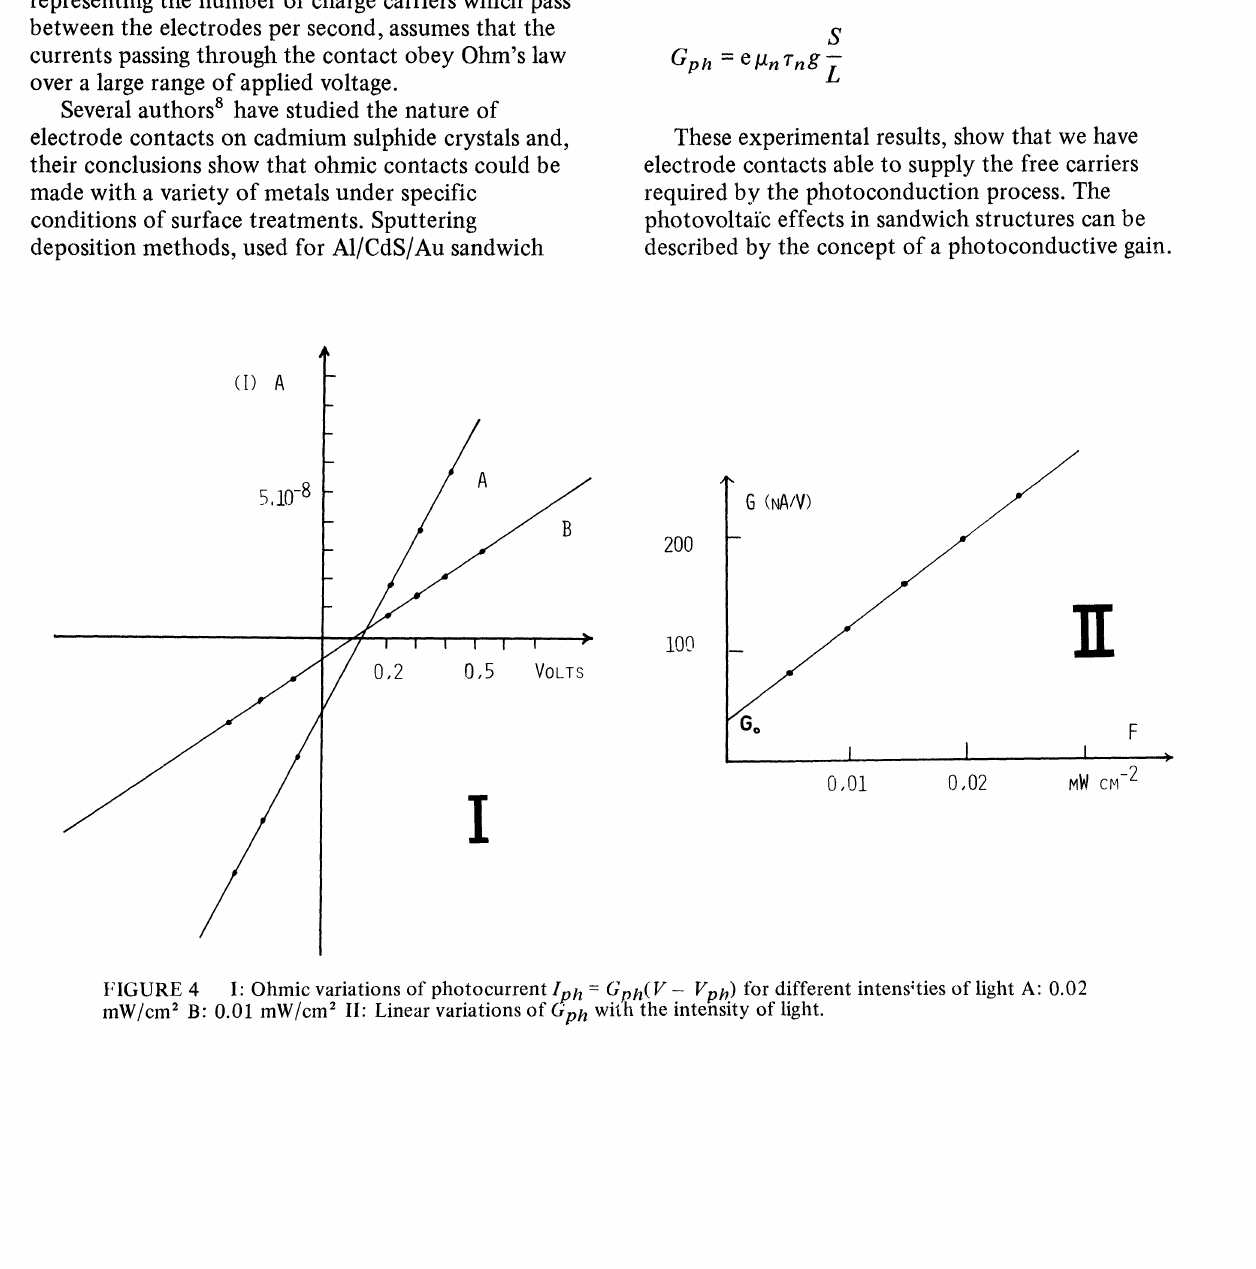
I: Ohmic variations of photocurrent Ioh- Gph(V- Vph) tbr different intensities of light A: 0.02 mW/cm B: 0.01 mW/cm II: Linear variations of Gph with the intensity of